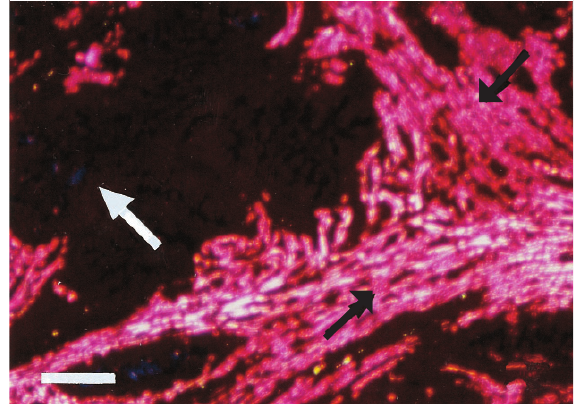
Fig. 10. Cross-section of parenchyma cells inside the knot with meristematic tissue, of vascular-cambium type (arrow head), close to infected areas, and producing tracheids. Bar=100 μ m (fuchsin-Astra blue).